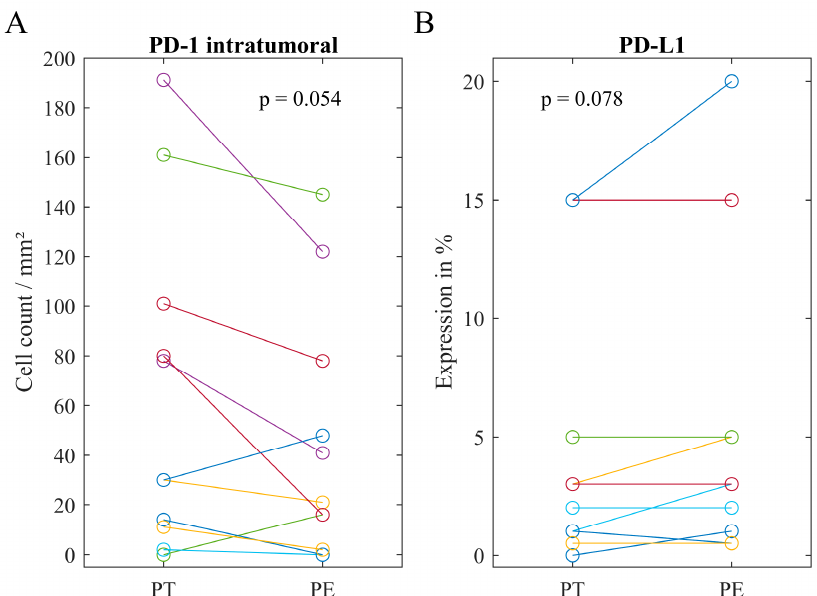
Figure 2. Scatter plots comparing immune cell phenotypes between primary tumor and the corresponding peritoneal lesion. ( A ) Counts of intratumoral PD-1 + (programmed cell-death protein 1) cells have been in tendencies higher in primary tumor. ( B ) PD-L1 (programmed cell-death ligand 1) expression has been slightly higher in peritoneum. p -value calculated by Wilcoxon signed-rank test. Cases with the value ‘0’ in primary tumor and peritoneum (A) n = 3 (B) n = 2 have been excluded from graph, but not from calculation.